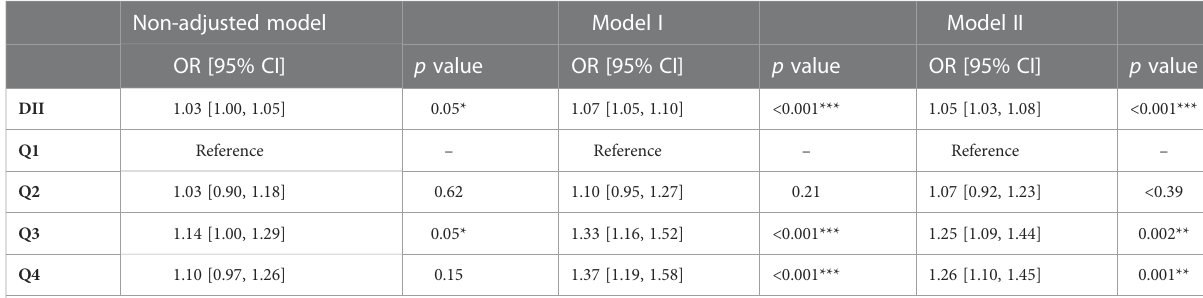
TABLE 4 Logistic regression analysis on the association between DII and hypertension in the sensitivity